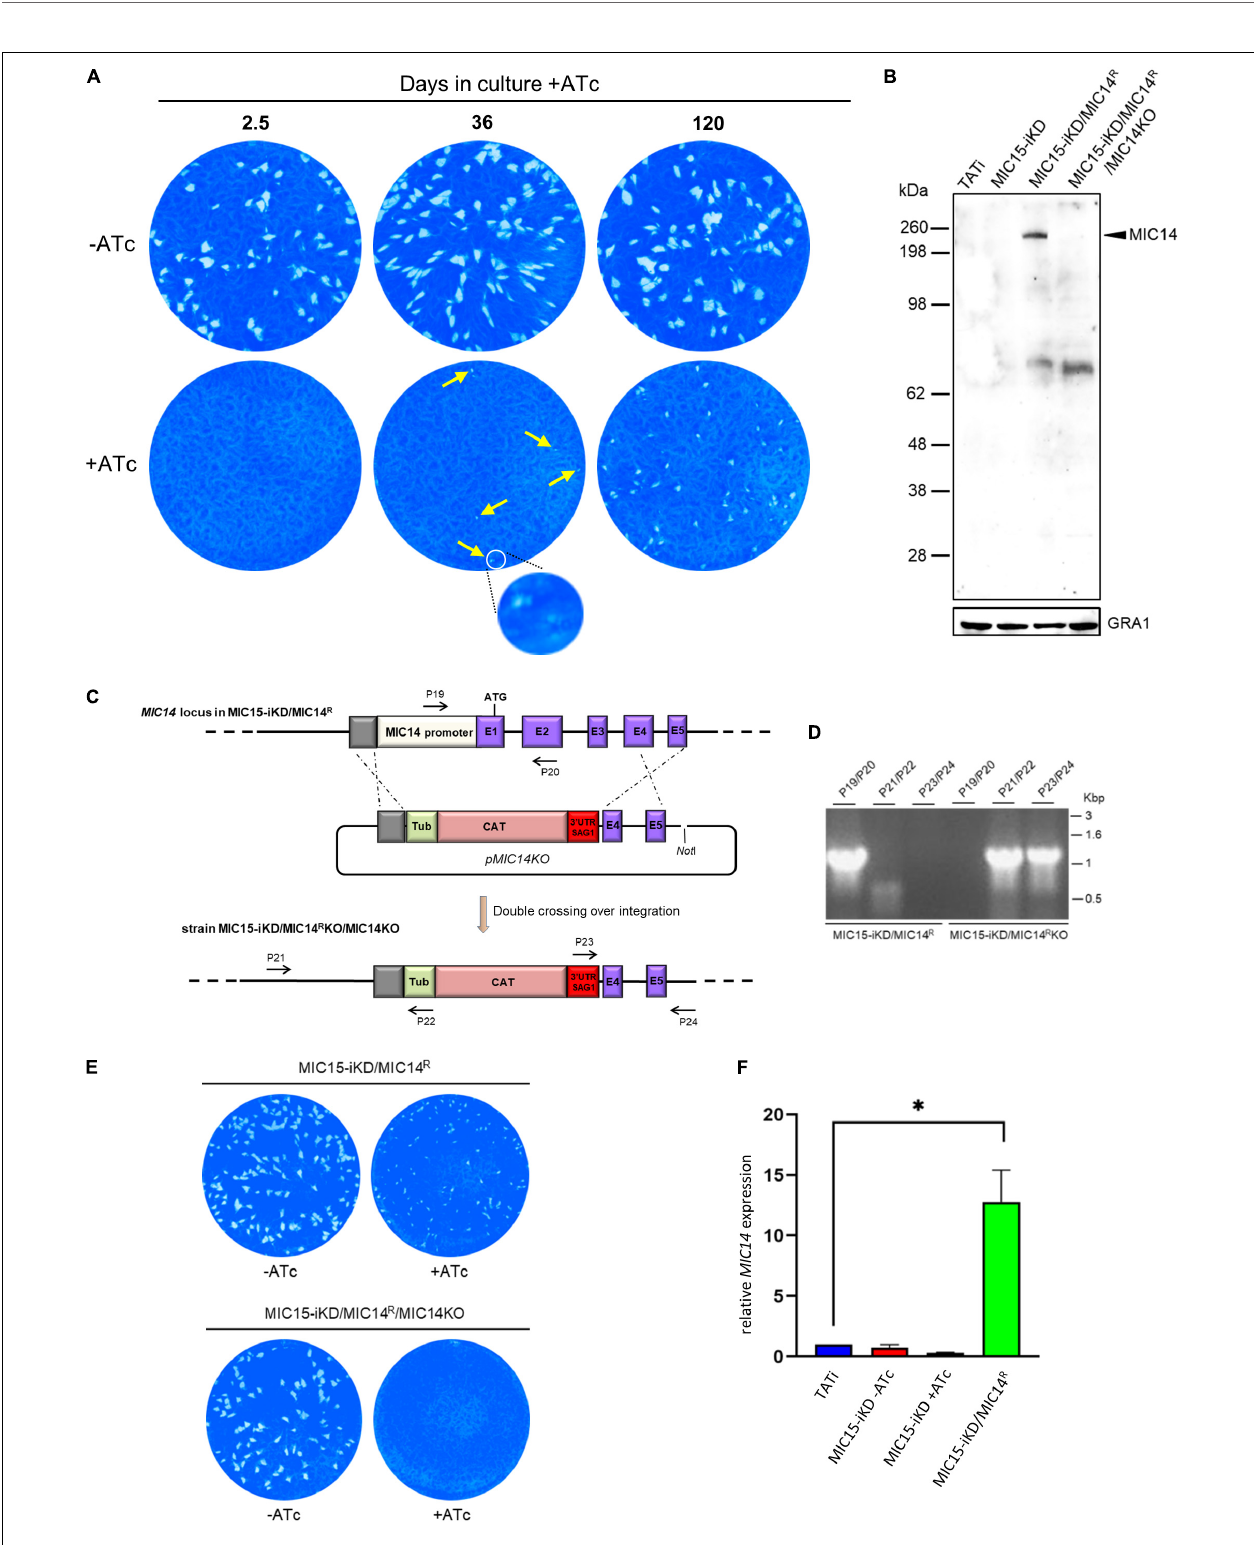
FIGURE 7 | Selection and characterization of a MIC15-iKD variant strain expressing MIC14. (A) MIC15-iKD tachyzoites cultured in presence of Atc for extended periods of time show rescue of the lytic phenotype. Minuscule plaques detected after 36 days of Atc treatment are indicated by arrows and a group of them, encircled in white, is shown at higher magnification. Parasites grown in presence of Atc for 120 days formed larger plaques, still significantly smaller than those produced omitting Atc from the assay. (B) Western blot analysis of strain MIC15-iKD/MIC14 R , which was cloned from MIC15-iKD parasites propagated in